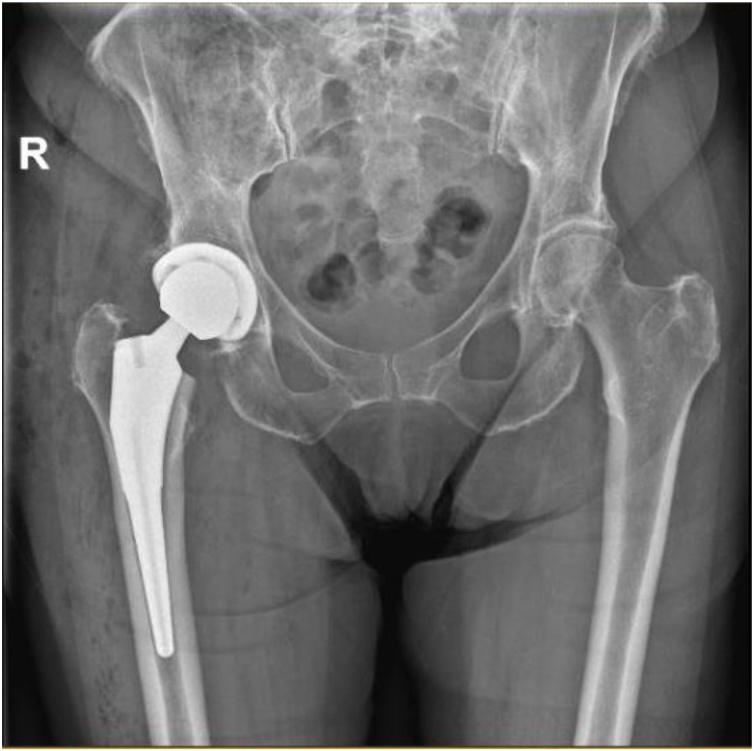
Plain X-ray shows no arguments of prosthetic loosening.